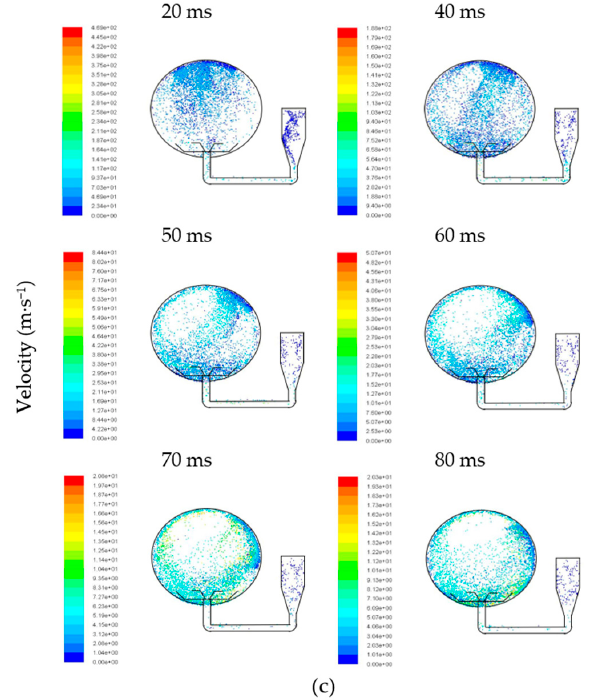
Figure 7. ( a ) Turbulence kinetic energy of Mg/air mixture, ( b ) turbulence kinetic energy of pure air, and ( c ) magnitude of particle position and velocity distribution during dispersion process.